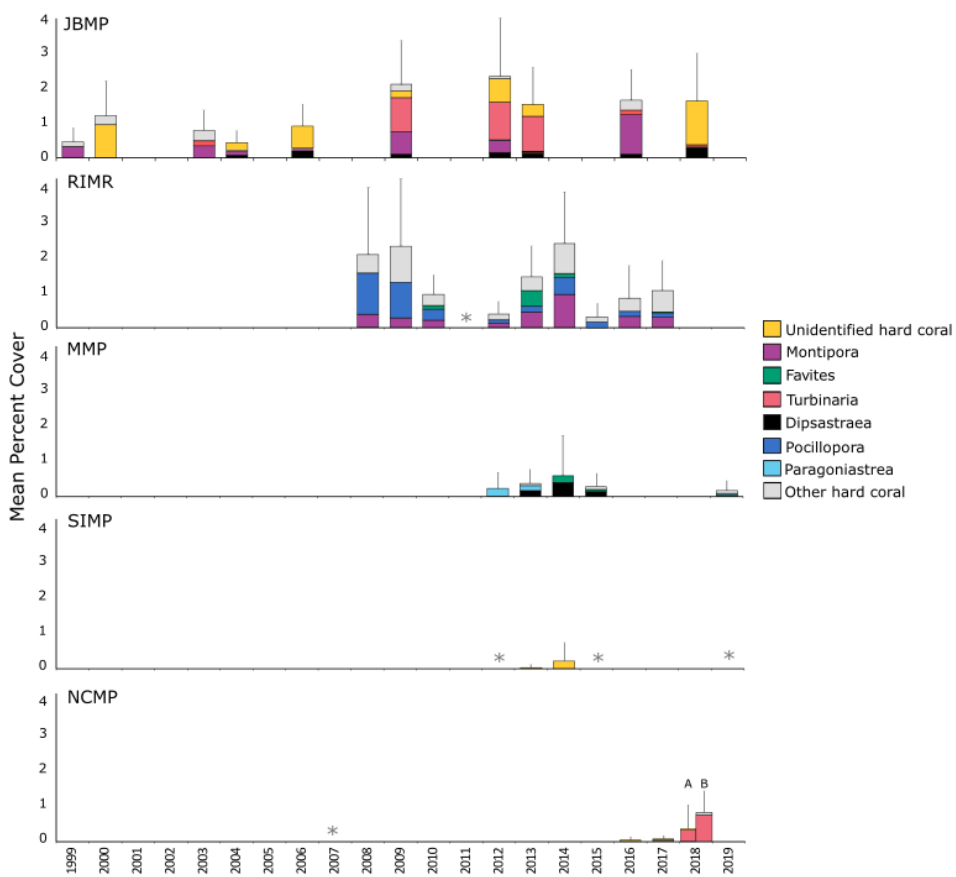
Figure 4. Mean % coverage of hard-coral genera for five marine parks/reserves in south-western Australia. Sites sampled were JBMP n = 44, RIMR n = 25, MIMP n = 8, SIMP n = 8, NCMP n = 20 (‘A’ diver quadrat data at depth < 15 m and ‘B’ tow-camera data at depth > 10 m). Error bars represent 95% CI about the mean total coverage. Data were derived using three survey techniques; SCUBA photo quadrat, in situ SCUBA quadrat and tow-camera quadrat, collected from transect replicates. For each marine park, the top three most abundant hard-coral genera are displayed, and the least common hard-coral genera are grouped as ‘other’. Asterisks (*) denote occasions where surveys were conducted but no coral was